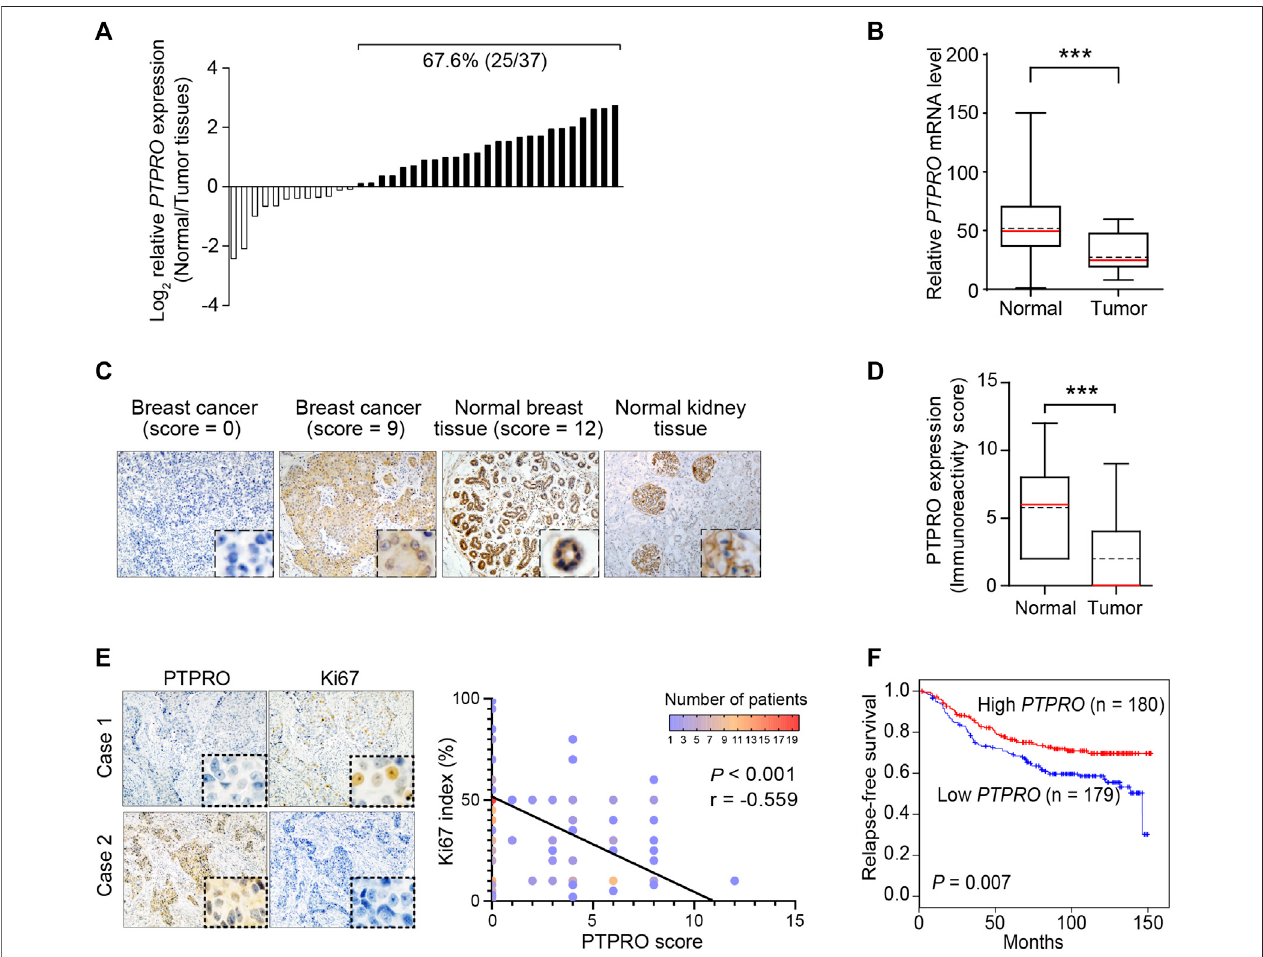
FIGURE 1 | Downregulation of PTPRO correlates with poor prognosis in ERBB2-positive breast cancer patients. (A) The mRNA level of PTPRO in cancer tissues and corresponding adjacent normal breast tissues was determined in 37 breast cancer patients. (B) Paired t-test revealed the signi fi cant alteration of PTPRO mRNA in tissue samples (*** p < 0.001). (C) Representative images are shown as IHC scores (0 – 9); Normal kidney and breast tissues were positive references. (D) The immunoreactivity scoresofPTPRO in normalbreast tissues and breast cancertissues werecomparedusingthe Mann-Whitney Utest (*** p < 0.001). (E) Images of IHC staining of PTPRO and Ki67 in serial sections of two representative human breast cancer specimens (left panel); Pearson ’ s correlation analysis of Ki67 index and PTPRO score in 180 human breast cancer specimens (right panel). (F) Relapse-free survival analysis in breast cancer patients according to PTPRO high and low expression levels (log-rank test). These data came from the publicly available cohorts (GSE3494, GSE7390, GSE6532, GSE1456, GSE2034; the top tertile (359 cases) of ERBB2 mRNA expression was assumed to be ERBB2-positive tumors).